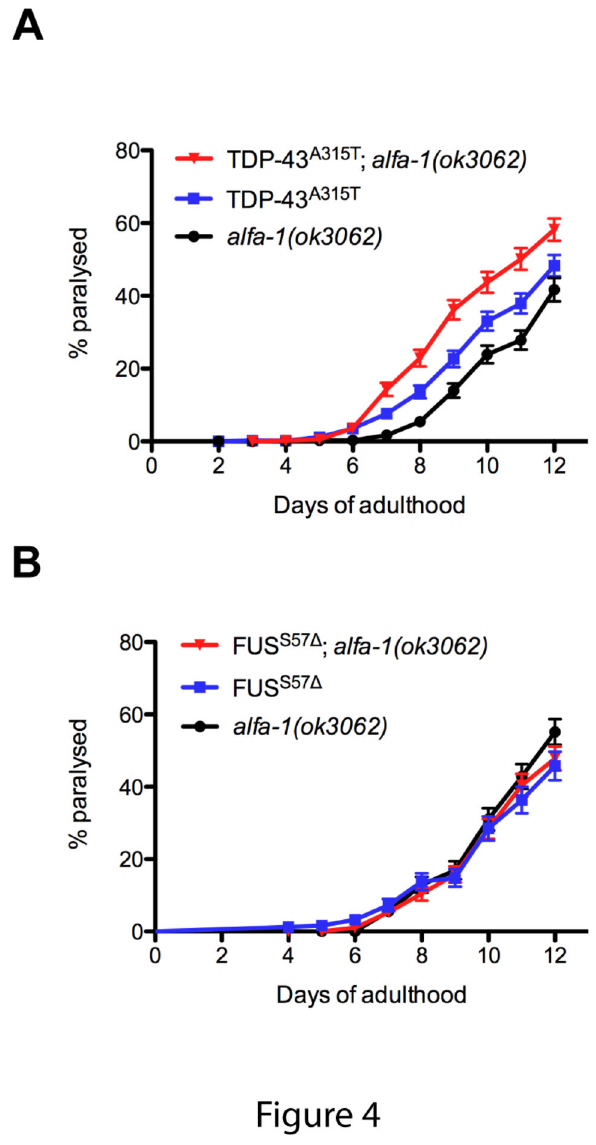
Figure 4. Genetic interactions between alfa-1(ok3062) , TDP-43 , and FUS. (A) TDP-43 A315T ; alfa-1(ok3062) worms had a higher rate of paralysis that either TDP-43 A315T or alfa-1(ok3062) worms alone (P<0.005). (B) FUS S57∆ worms, alfa-1(ok3062) worms, and FUS S57∆ ; alfa-1(ok3062) worms showed similar rates of paralysis.